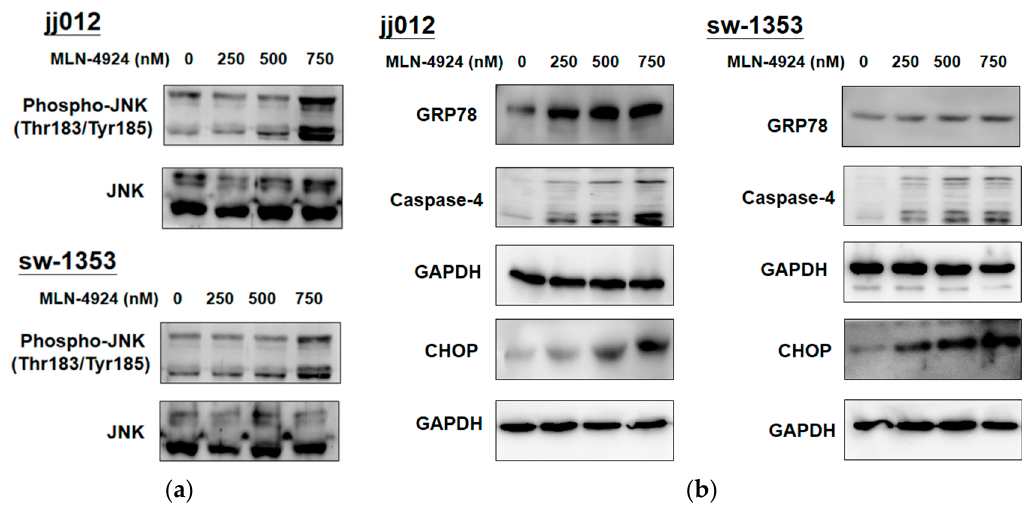
Figure 4. MLN4924 activated ER stress-related apoptosis in human chondrosarcoma cells. The jj012 and sw-1353 cells were treated with various concentrations of MLN4924 (250, 500, and 750 nM) and DMSO (for the control group) for 48 h. After they were harvested, cell lysates were analyzed by a Western blot analysis that used specific antibodies to molecules related to ER stress-induced apoptosis, including ( a ) c-Jun N-terminal kinase (JNK) and phospho-JNK, ( b ) GRP78, CHOP, and caspase-4. The results are representative of at least three independent experiments.